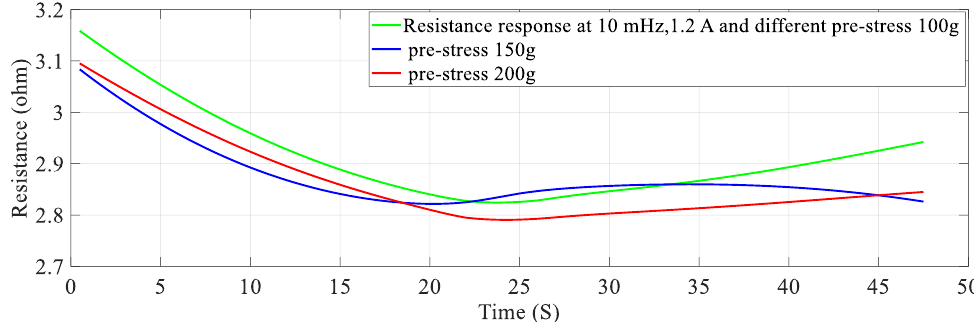
Figure 13. Resistance response at different Pre-Stresses.